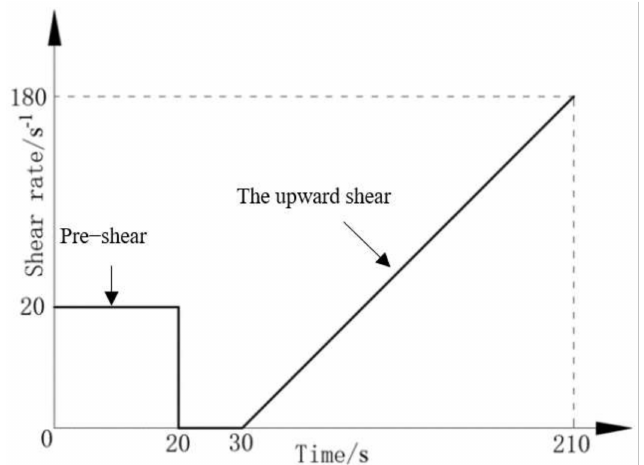
Figure 4. The test